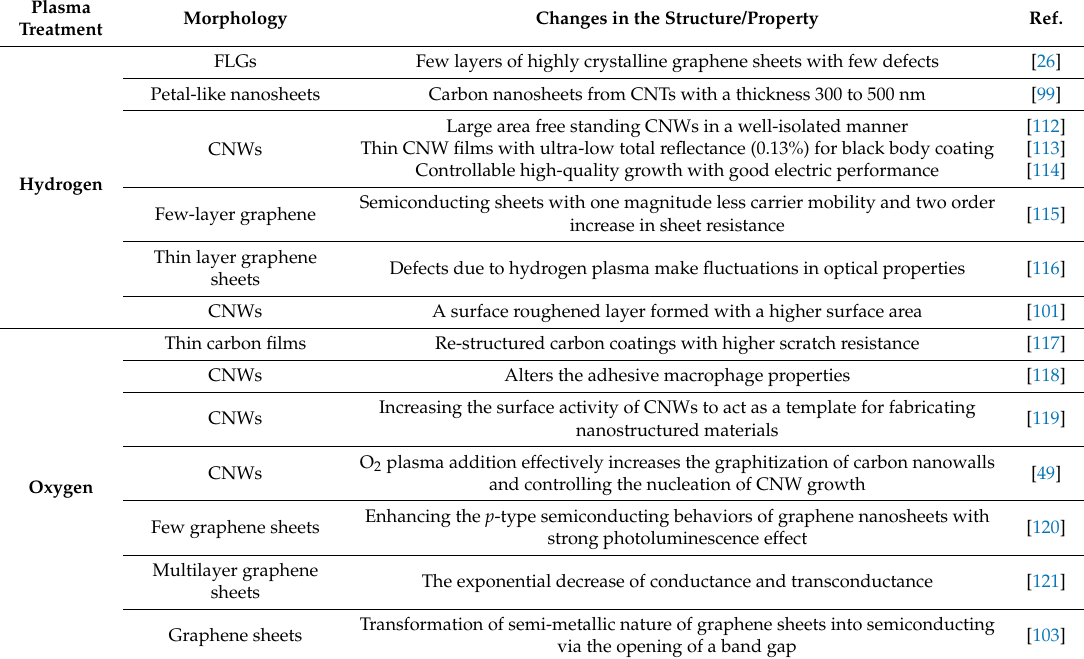
Table 3. Different plasma treatments on 2D carbon nanostructures and observed modifications. Plasma